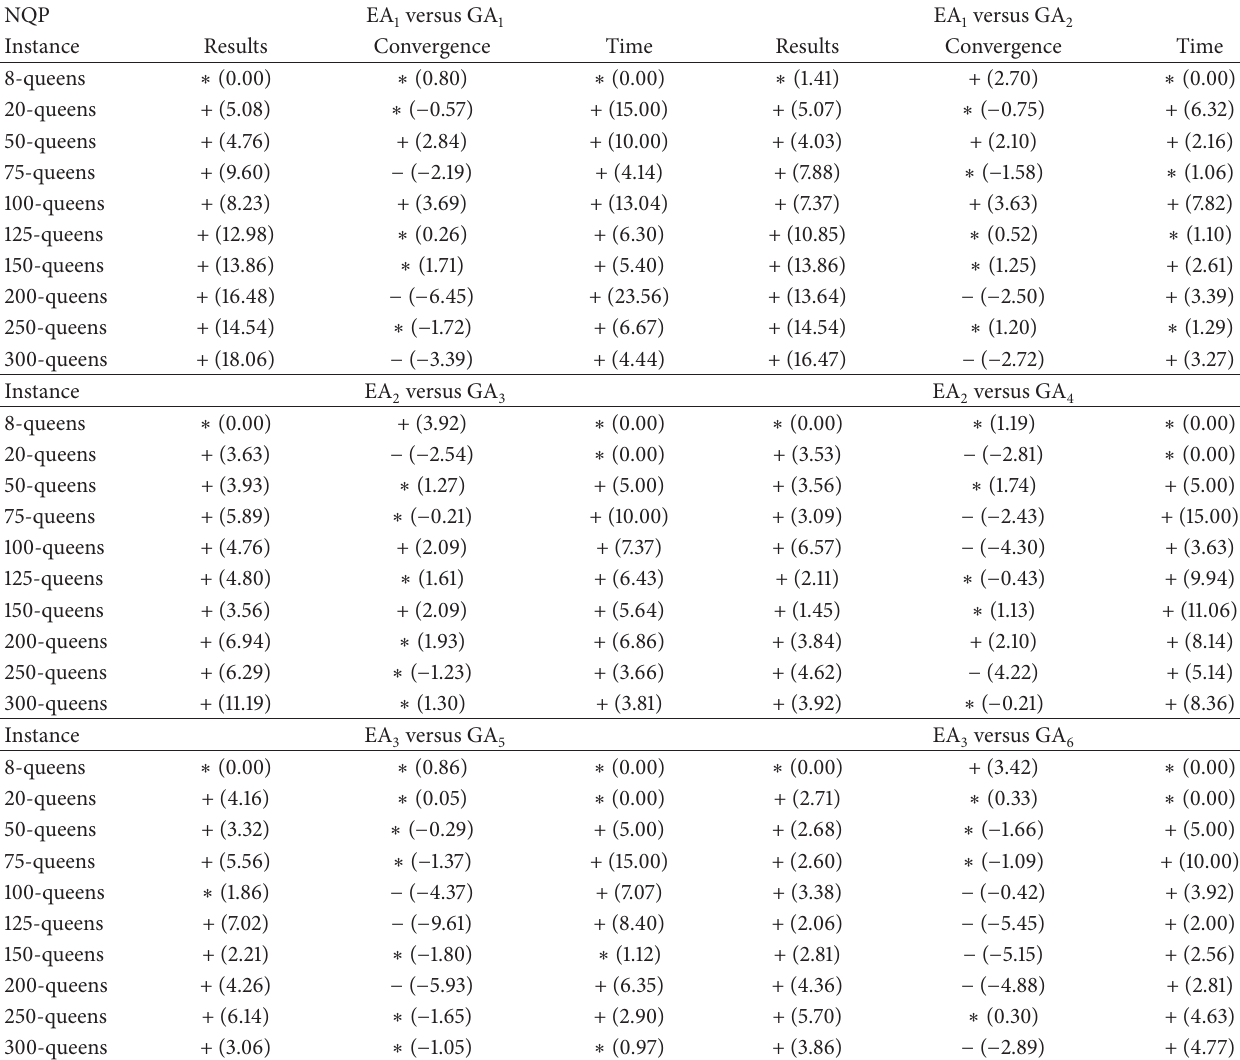
Table10: 𝑧 -testforNQP.“+”indicatesthatEAisbetter.“ − ”depictsthatitisworse.“ ∗ ”indicatesthatthedifferencebetweenthetwoalgorithms is not significant (at 95% confidence